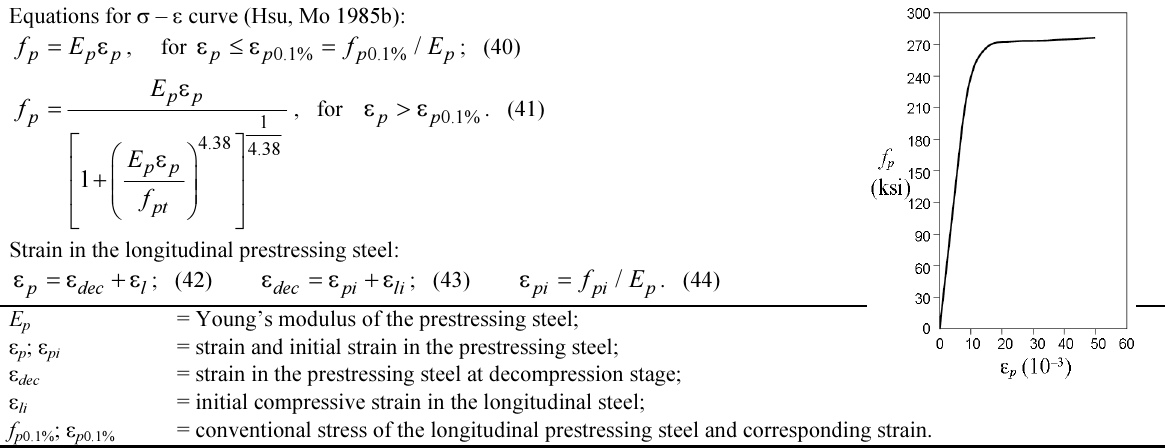
Table 5. σ – ε relationship for prestressing steel Equations for σ – ε curve (Hsu, Mo 1985b):